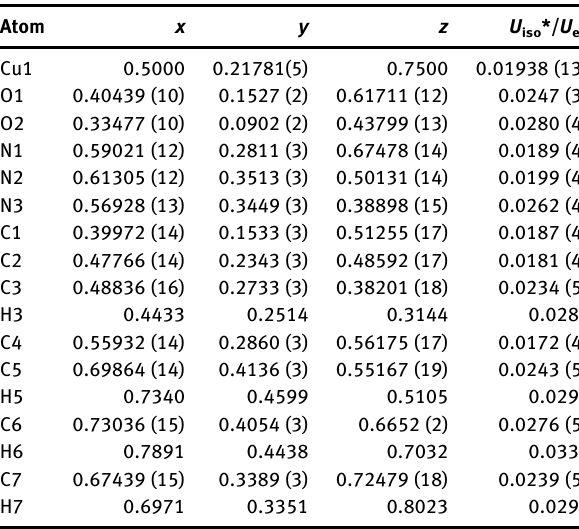
Table  : Fractional atomic coordinates and isotropic or equivalent isotropic displacement parameters (Å 